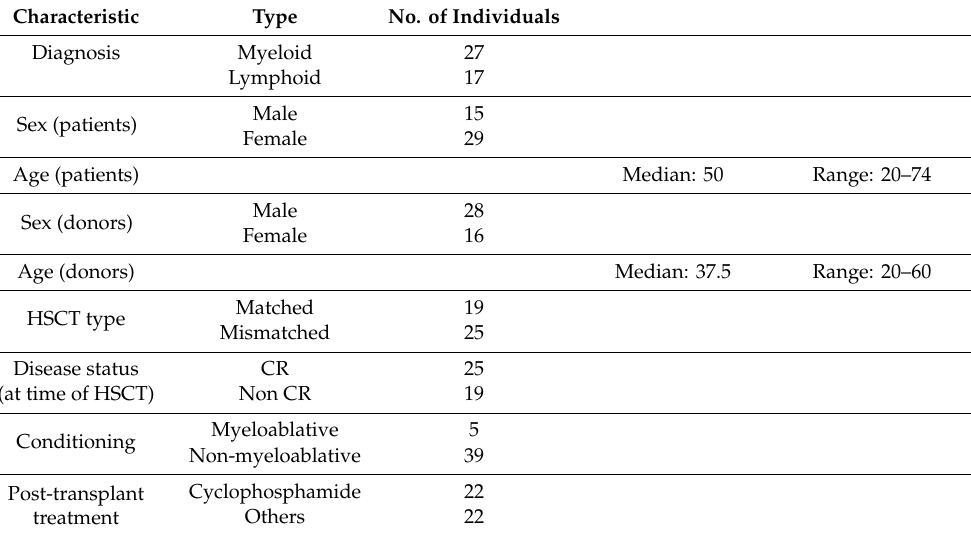
Table 1. Clinical structure of the study